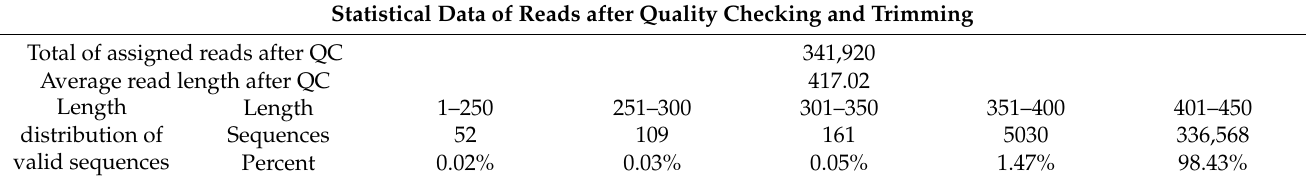
Table 1. Quality metrics of the trimmed sequences.